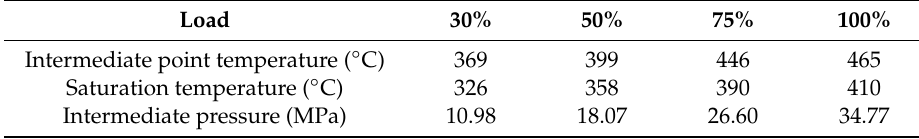
Table 4. Critical intermediate point temperature of the reference system under four loads.